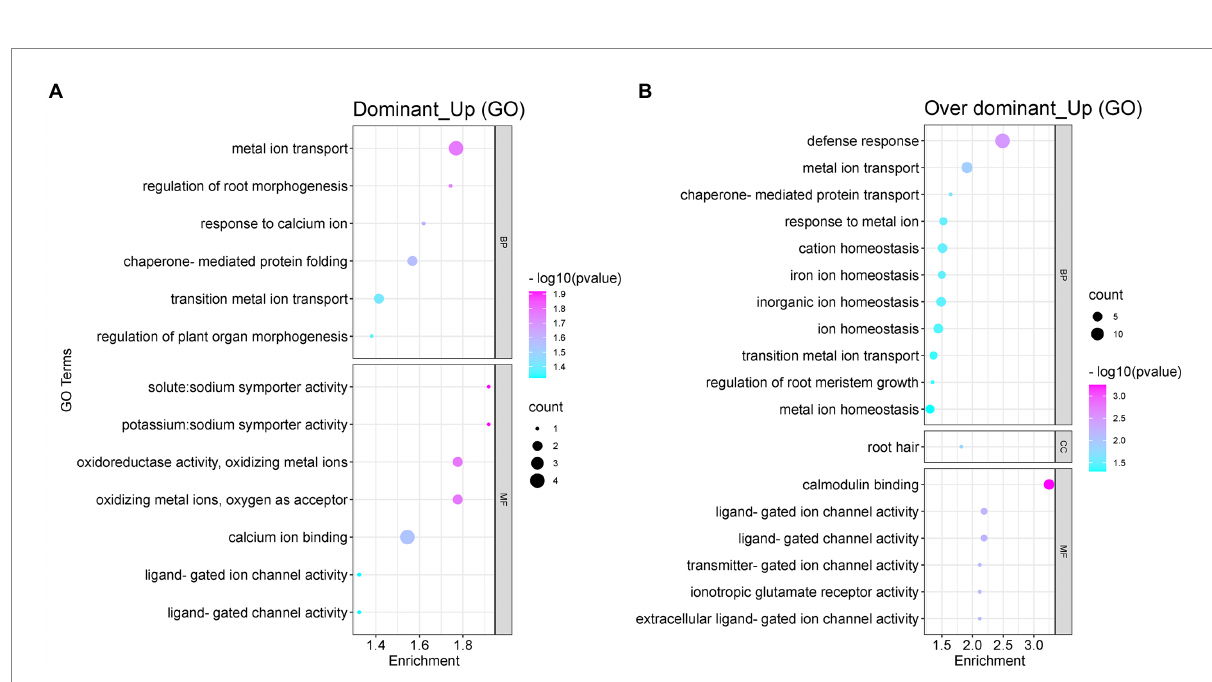
FIGURE 5 The GO functional enrichment analysis of the non-additive upregulated DEGs. (A) The GO functional enrichment analysis of the upregulated dominant DEGs. (B) The GO functional enrichment analysis of the upregulated over-dominant